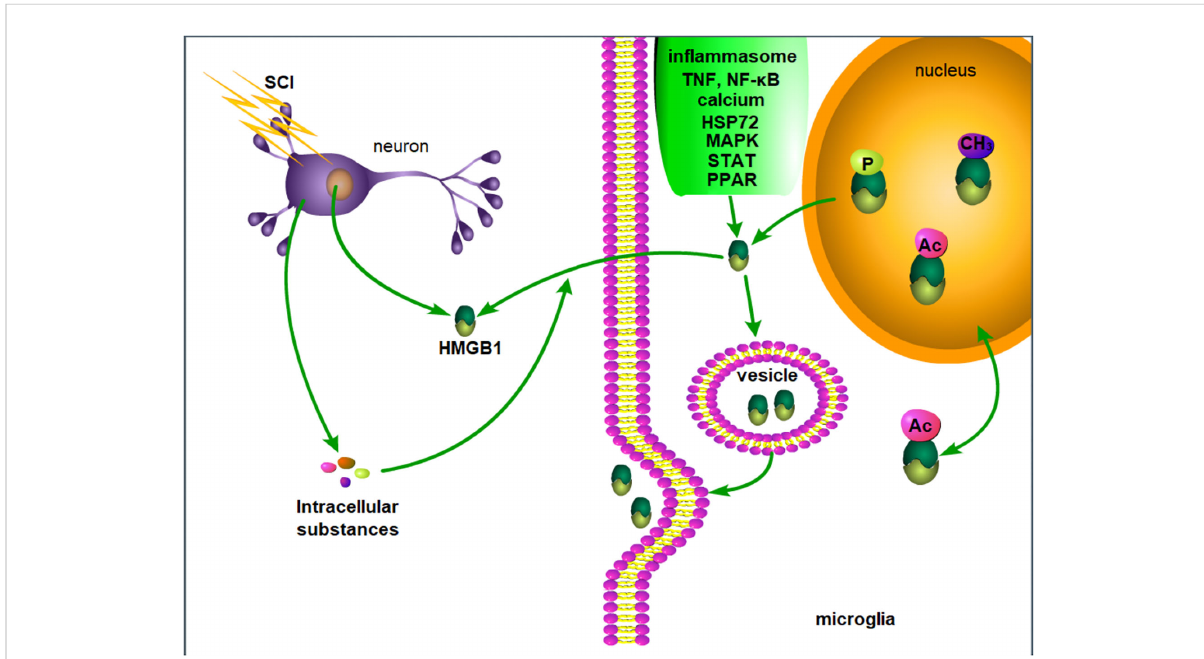
FIGURE 1 Possible mechanism of HMGB1 release after SCI. After SCI, injured neurons passively release HMGB1, and the intracellular substances released by necrotic neurons and in fl ammation lead to the active release of HMGB1 by microglia. P, phosphorylation. Ac, acetylation. CH3,